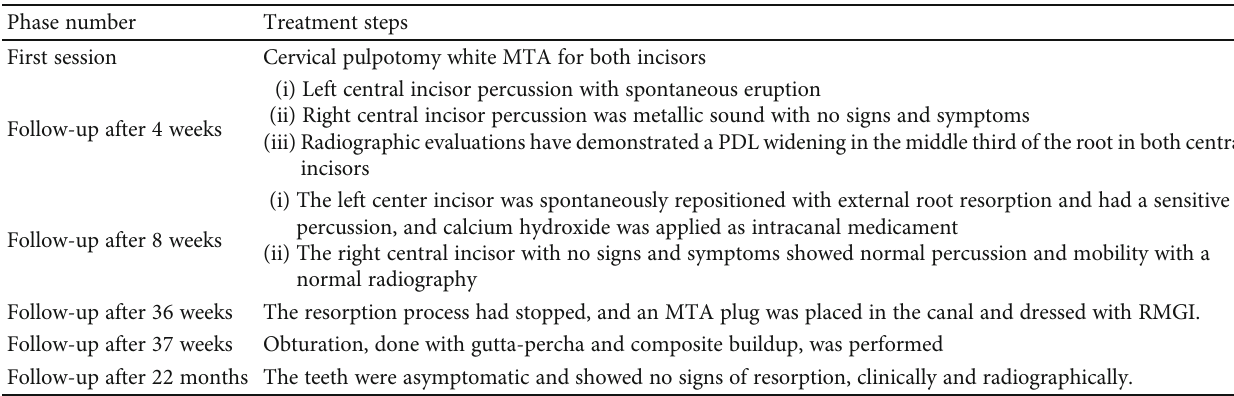
Figure 8: (a) Follow-up after 22 months. (b) Radiography after 22-month follow-up. Table 3: Clinical